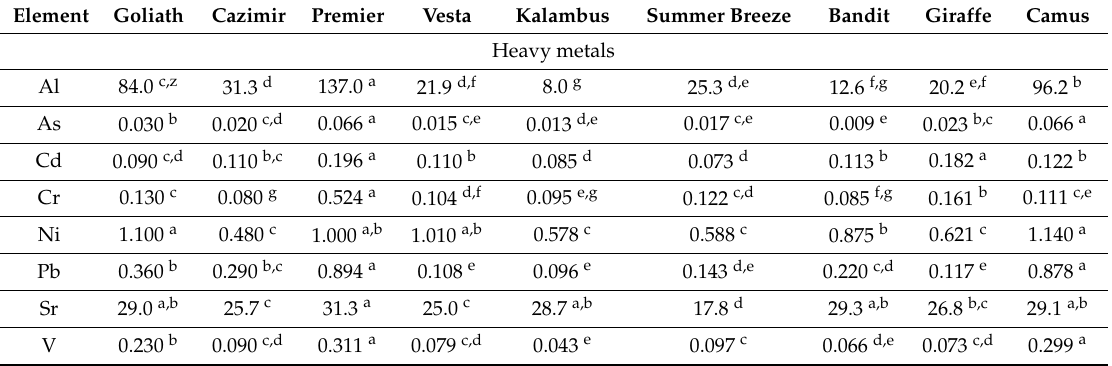
Table 5. Heavy metal concentration in A. porrum pseudo-stems (mg/kg d.w.).